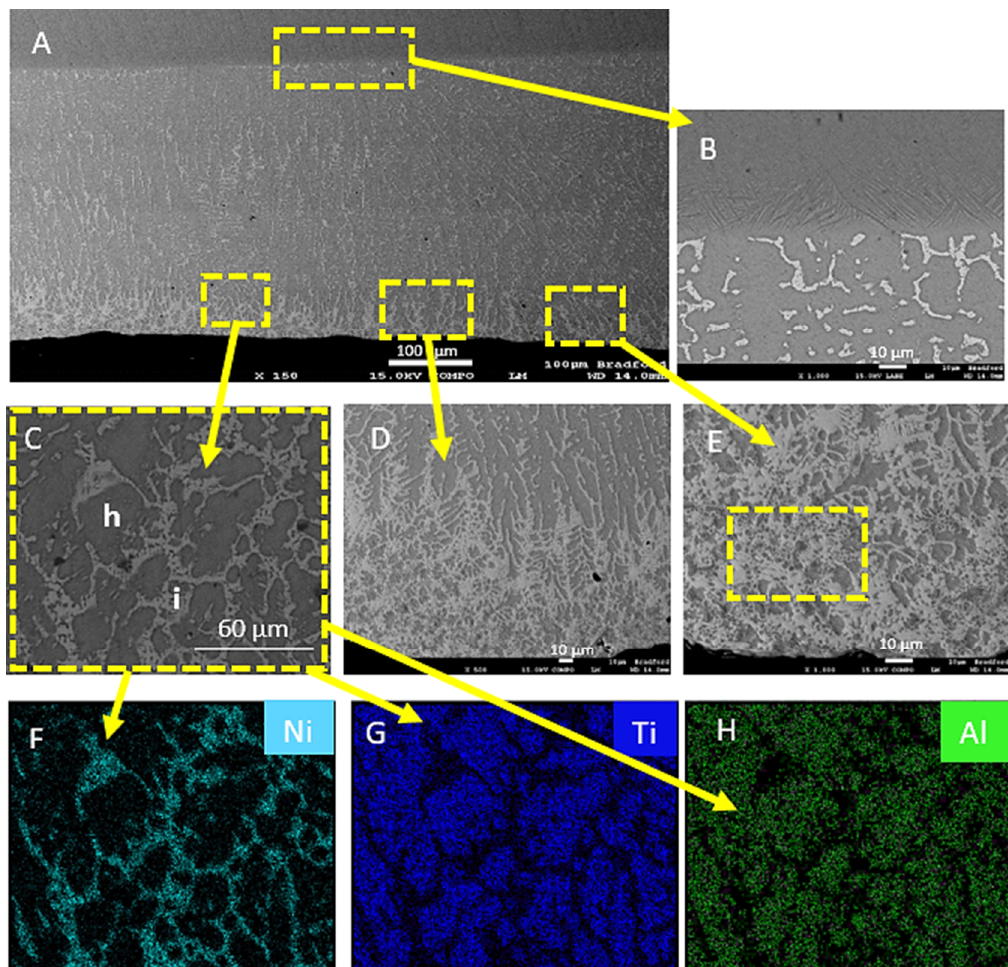
Figure 5. ( A ) Ti-6Al-4V sample electrodeposited with Ni / Al 2 O 3 + 250 nm diameter TiO 2 particles and surface melted with a welding current of 50 A. ( B ) HAZ and ( C ) grain boundary region. ( D ) Particle segregation to the top layer. ( E ) Detailed view of the phase formed at the surface EDS maps for ( F ) Nickel; ( G ) Titanium; (H) Aluminium.